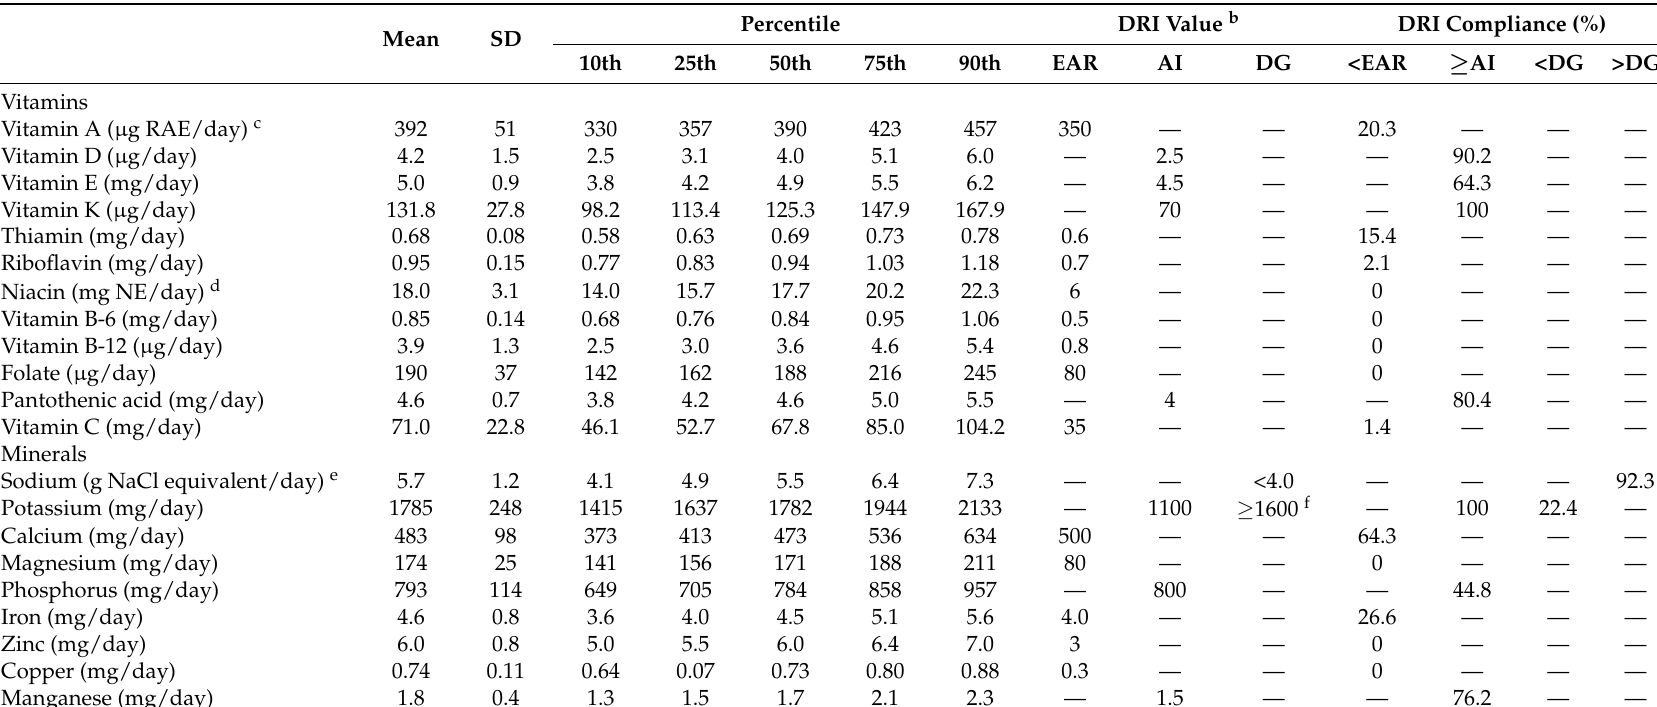
Table 4. Usual intakes of vitamins and minerals from foods and beverages for Japanese boys aged 3–5 years ( n = 143) a